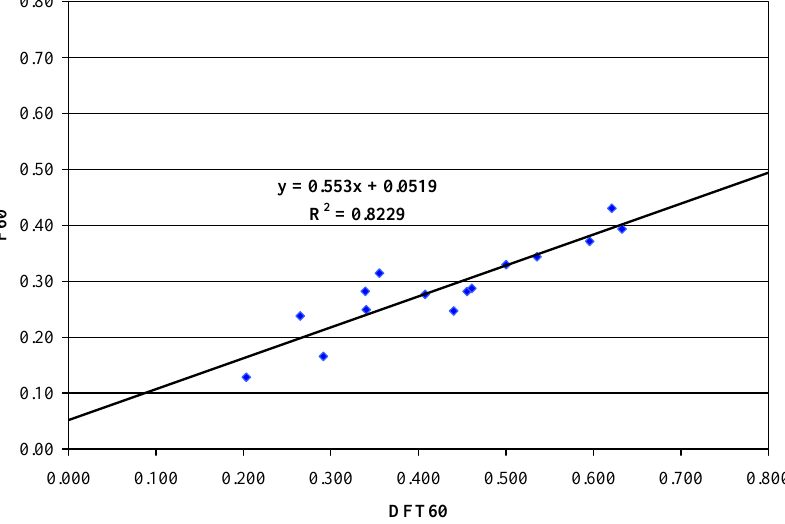
Fig. 8. F60 versus DFT measurements at 60 km/h speed (porous samples